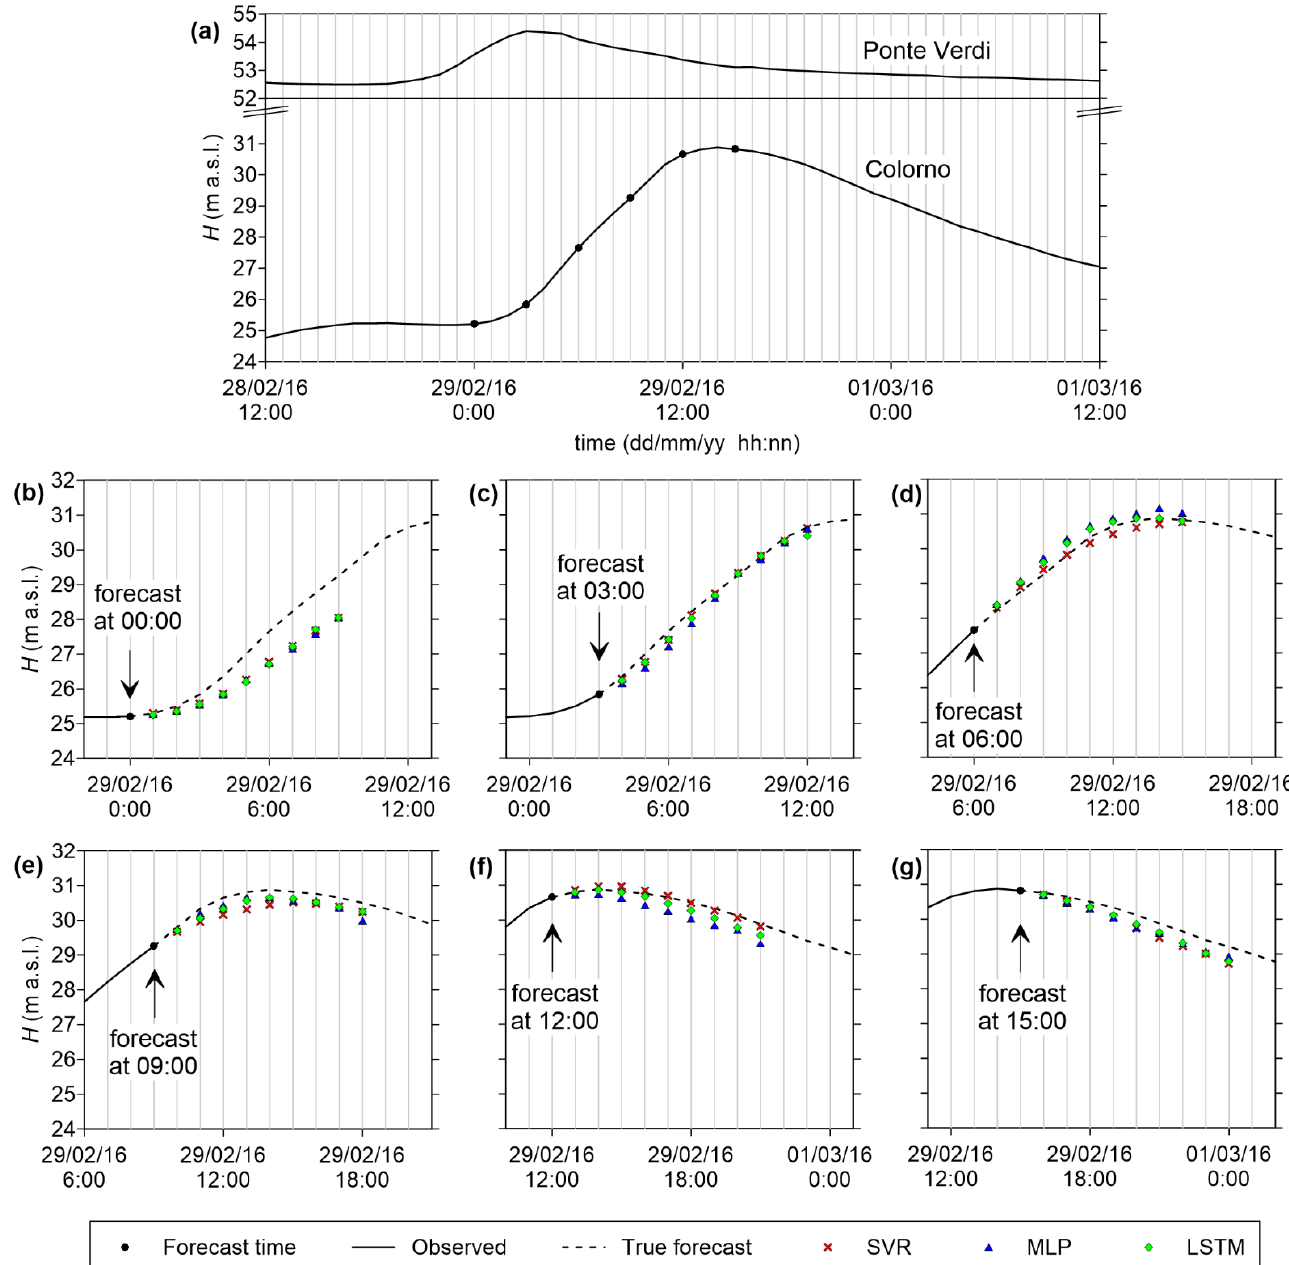
Figure 10. Example of application for real-time forecasting of flood stages in Colorno: ( a ) observed levels for the event of 28 February–1 March 2016 (large Parma River flood) at Colorno and Ponte Verdi stations; ( b – g ) 1 to 9 h-ahead forecasted levels by SVR, MLP, and LSTM. In all plots, vertical grid lines are hourly spaced.